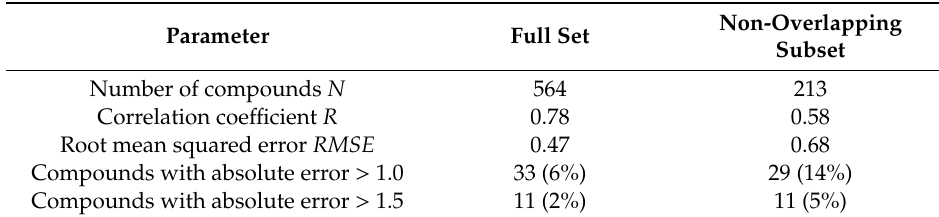
Figure 5. Comparison of the experimental and predicted LogBB values for the external validation dataset. The compounds overlapping with our training set are shown as blue diamonds and the non-overlapping compounds are shown as red circles. Table 1. Statistical parameters for the comparison of experimental and predicted LogBB values for the external validation dataset.